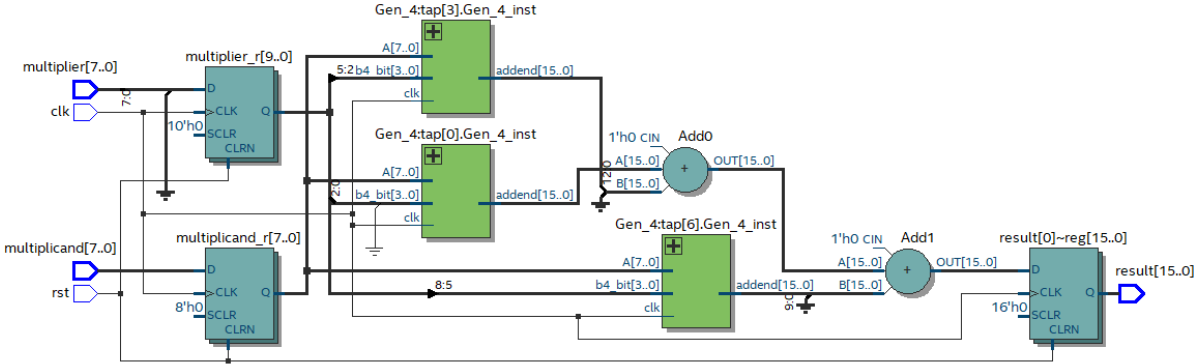
Figure 9. RTL of TBTM multiplying the two input codes (multiplier and multiplicand) synthesized by Quartus Prime for n = 8.